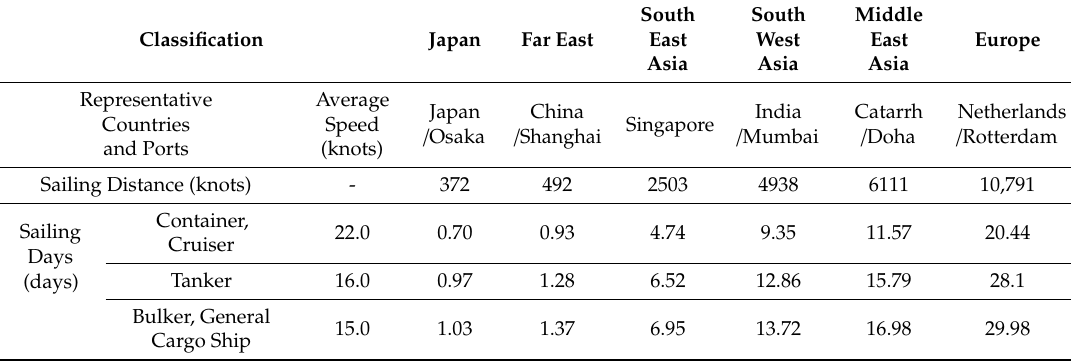
Table 13. Sailing Distance and Sailing Days of Main Area of Busan Port Origin